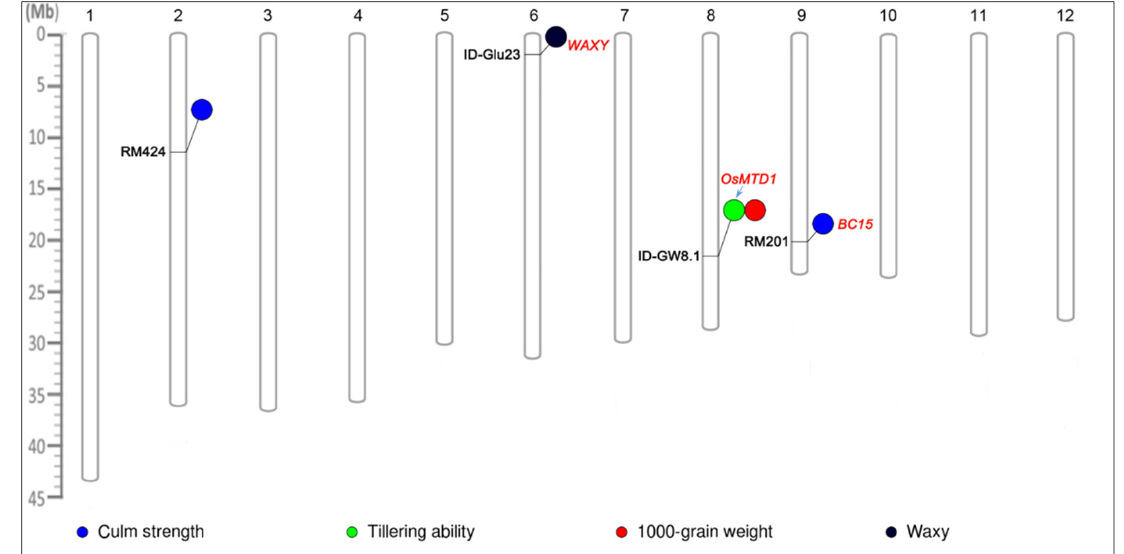
Figure 5. Physical locations of the significant marker-trait association detected by MLM (Q + K) based on the tool PhenoGram (http://visualization.ritchielab.psu.edu/ (accessed on 3 July 2021)). Each chromosome was manually rearranged from bottom to top based on a ruler.